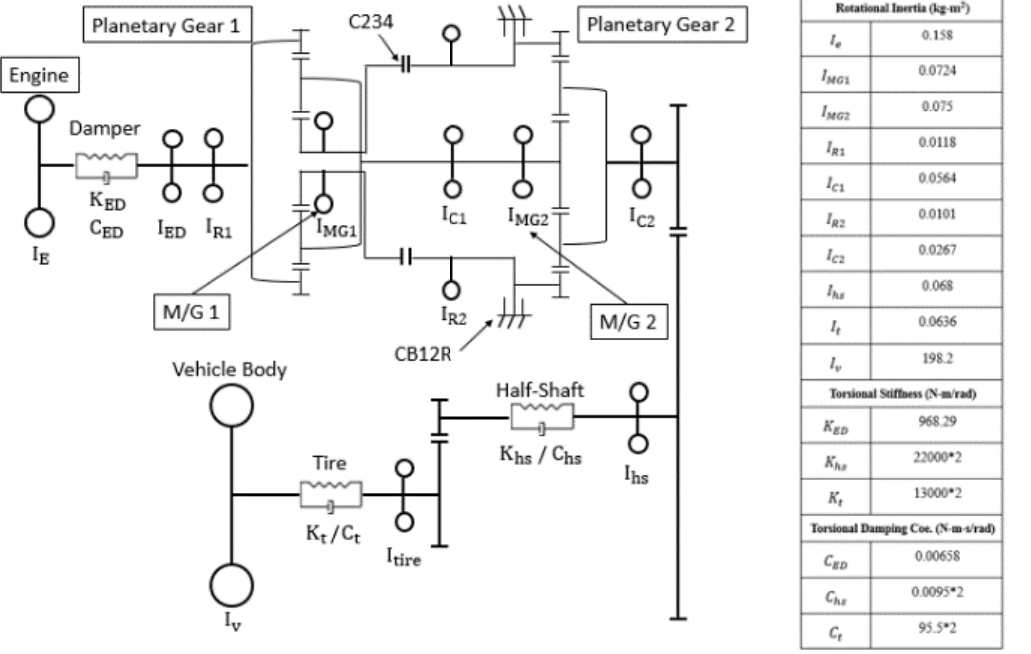
Figure 1. Schematic diagram of a two-mode power-split hybrid system.